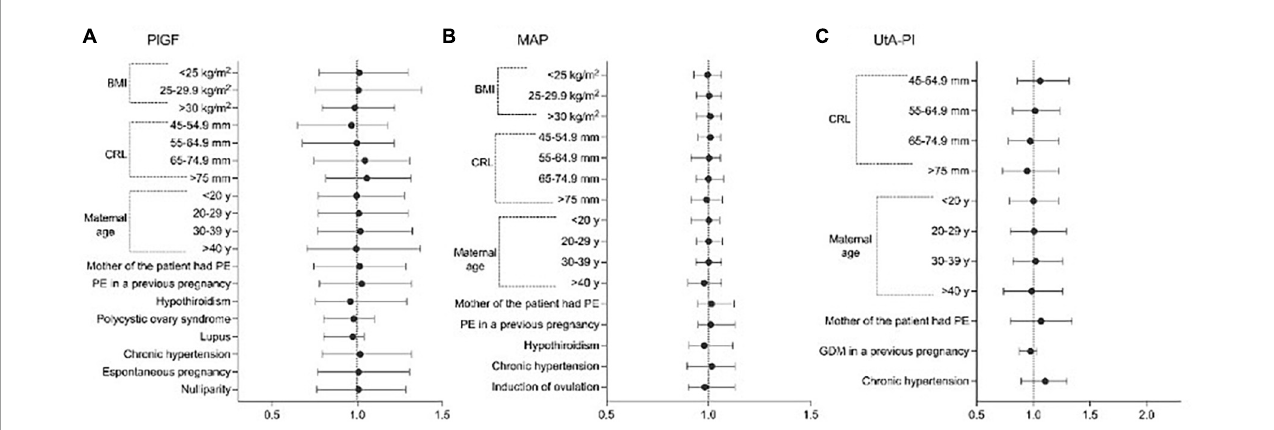
FIGURE1 Significant variables affecting the distribution of Log values of; (A) placental growth factor (PlGF), (B) mean arterial pressure (MAP), and (C) uterine artery pulsatility index (UtA-PI), plotted on multiples of the median (MoM) scale among healthy